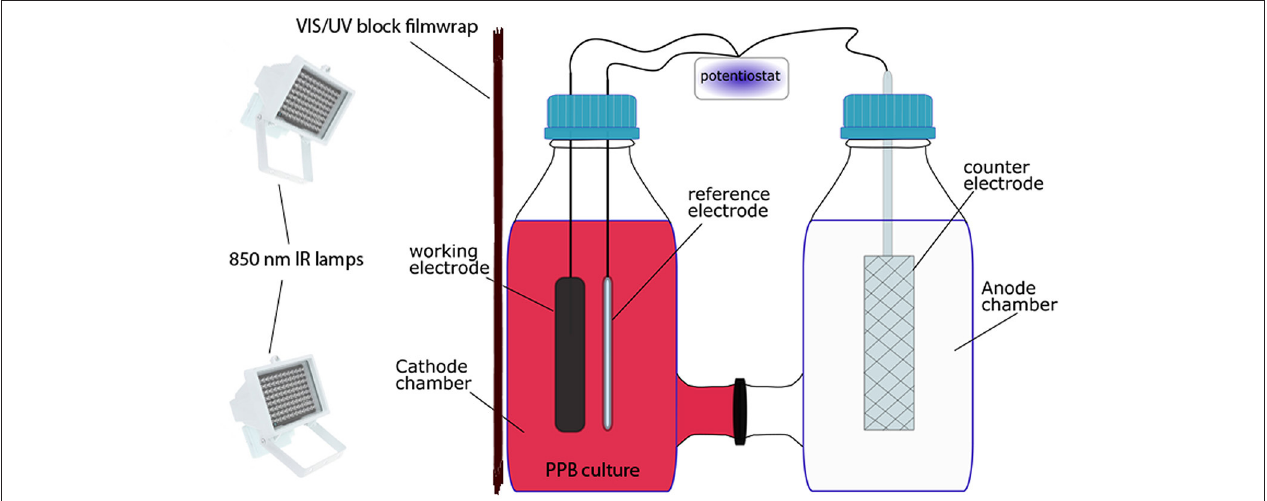
FIGURE 1 | Experimental set-up of the foto-bio-electrochemical H-cell device.